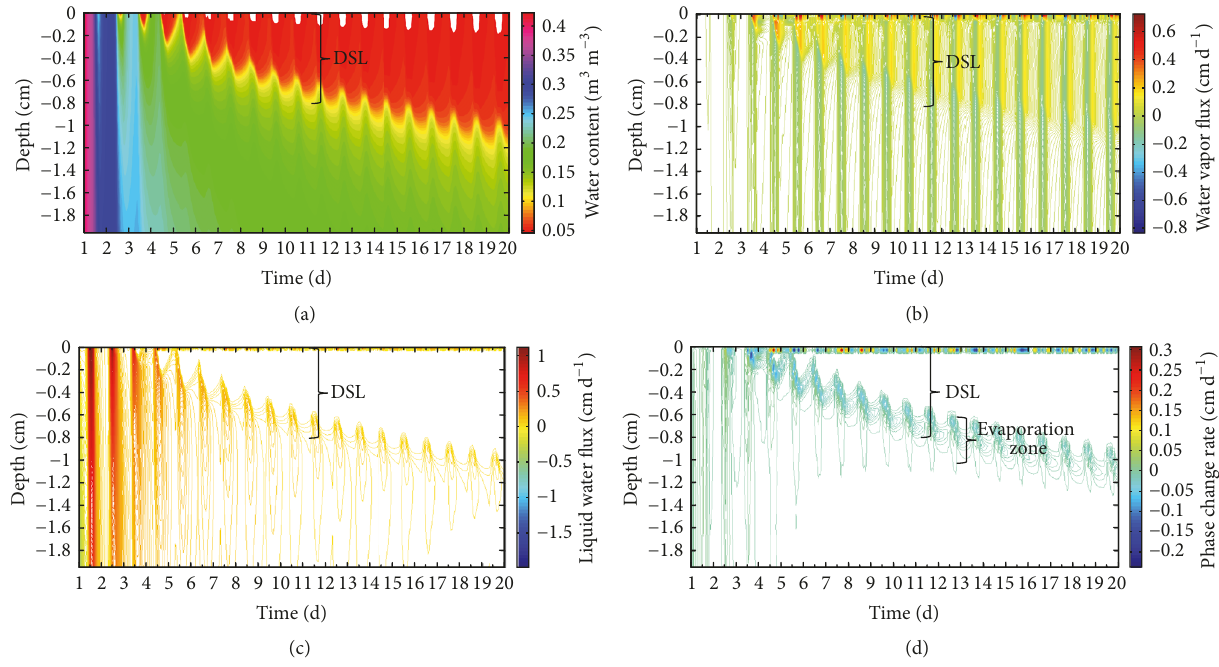
Figure 9: The spatiotemporal evolutions of (a) water content, (b) water vapor flux, (c) liquid water flux, and (d) evaporation zone during the drying